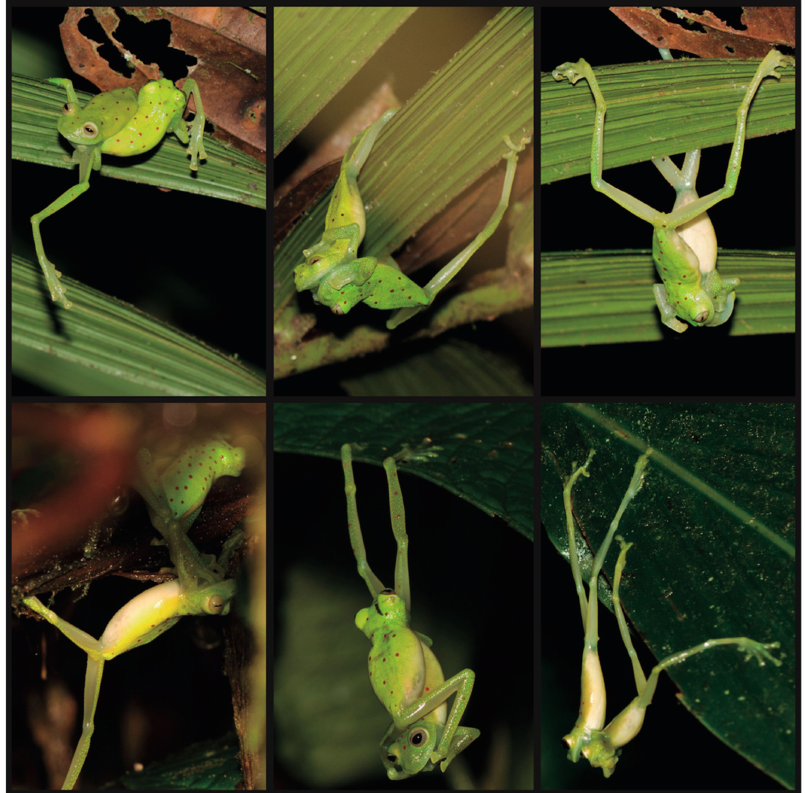
Figure 6. Combat behavior in glassfrogs. Note diversity of positions. Illustrated species: Nymphargus grandisonae . Photos by Carl R.